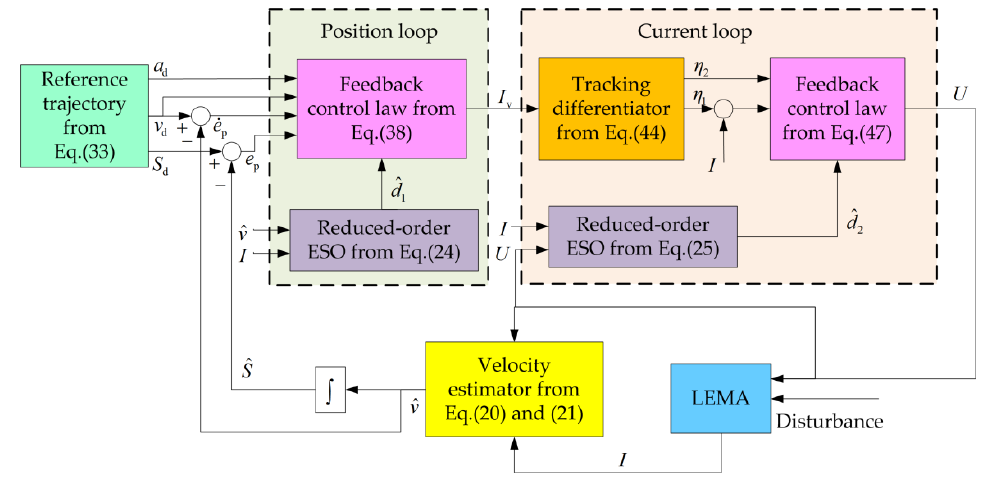
Figure 5. Block diagram of the whole control algorithm.